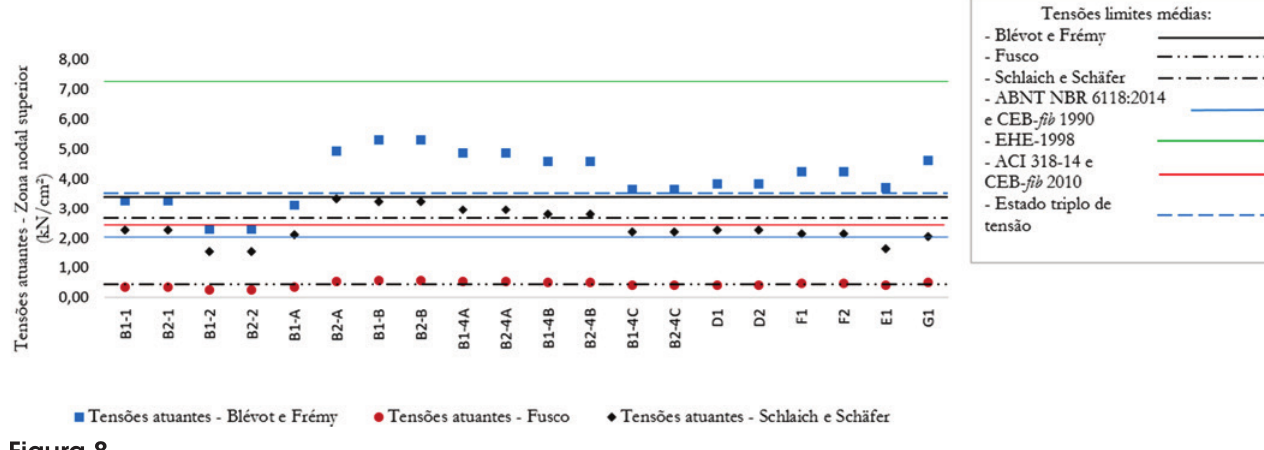
Modelos ensaiados por Mautoni [5] × σ